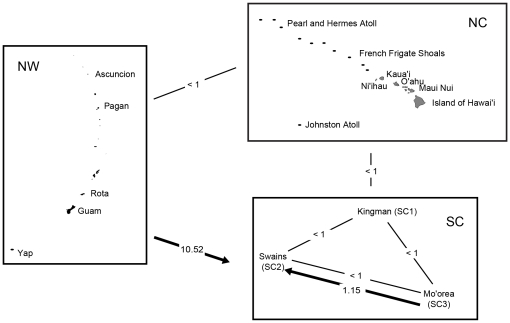
MIGRATE analysis of source and sink dispersal pathways of Acanthaster planci populations between regions in the central Pacific.The arrow points to the recipient region. Where arrows do not exist, Nem estimates were <1 effective migrant per generation. Region codes are as follows: SC = south central Pacific, NC = north central Pacific, and NW = northwestern Pacific.